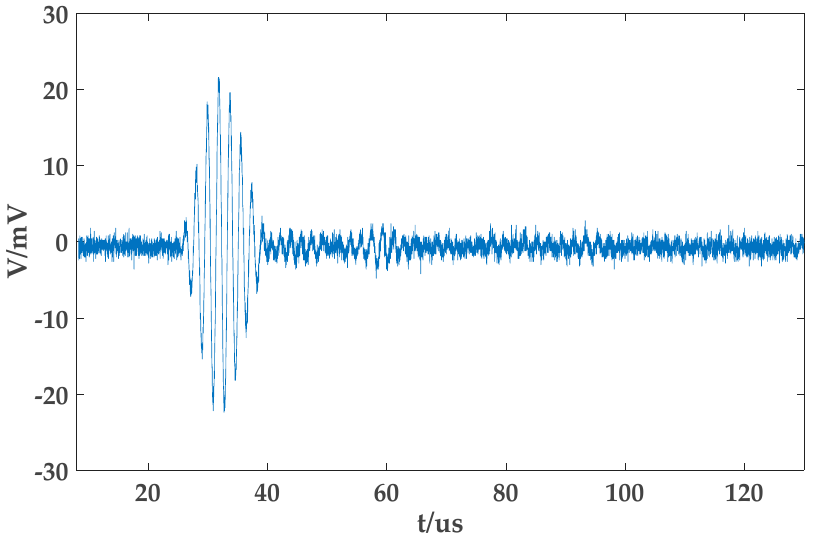
Figure 3. Single mode signal received in non-damaged sheet.